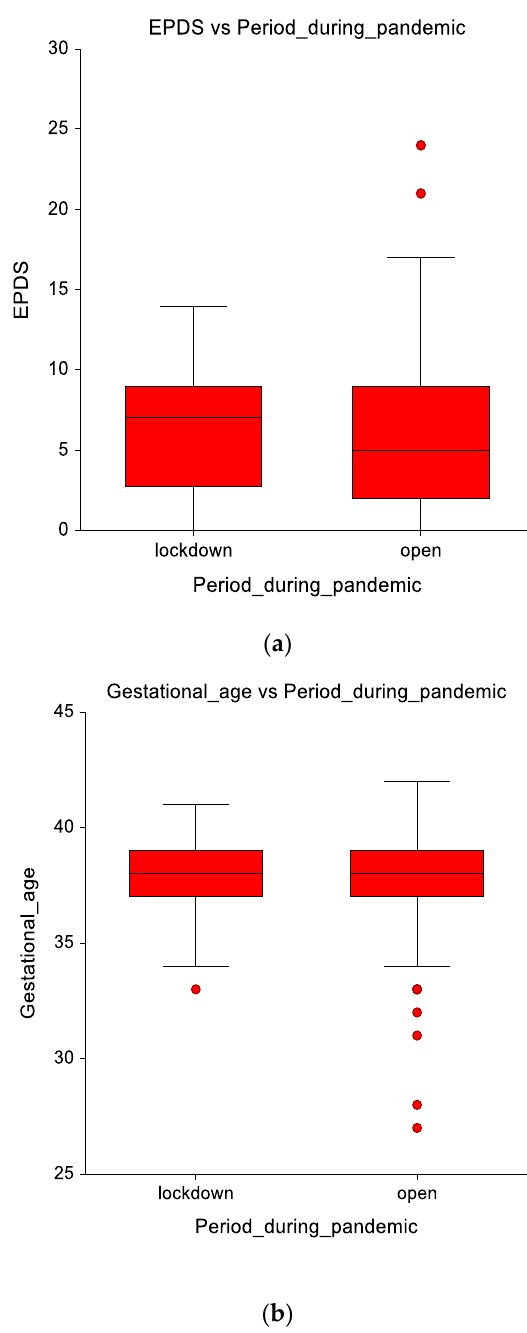
Figure 1. Comparison between the two study groups: lockdown and open of mean EPDS scores ( a ) and mean Gestational age (weeks) ( b ).